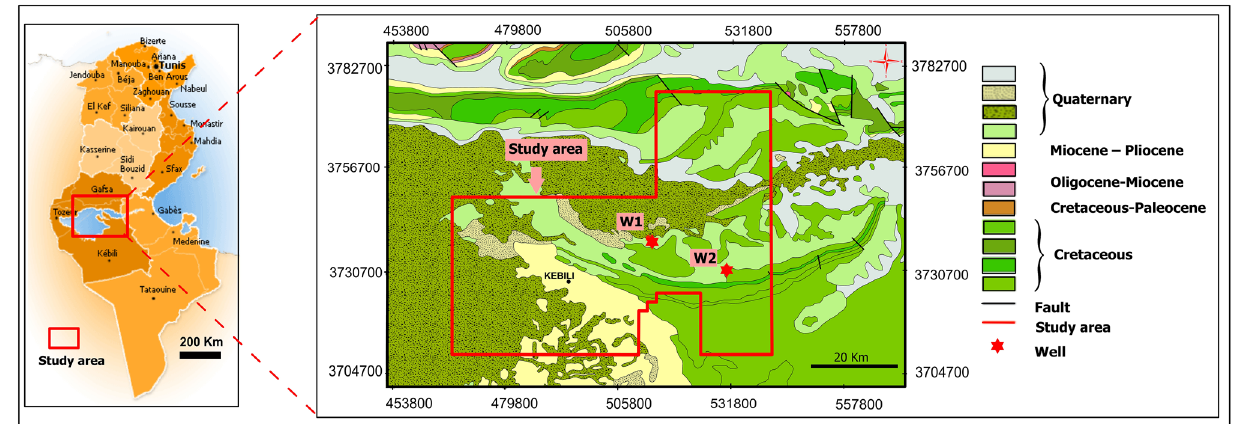
Fig. 2 Study area and petroleum wells